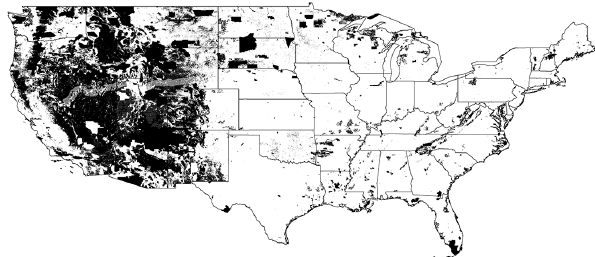
Figure 6. Locations of federal and Indian lands in the conterminous US administered by the five primary federal agencies with wild- land fire-management programs (i.e., BIA, BLM, FWS, NPS, and